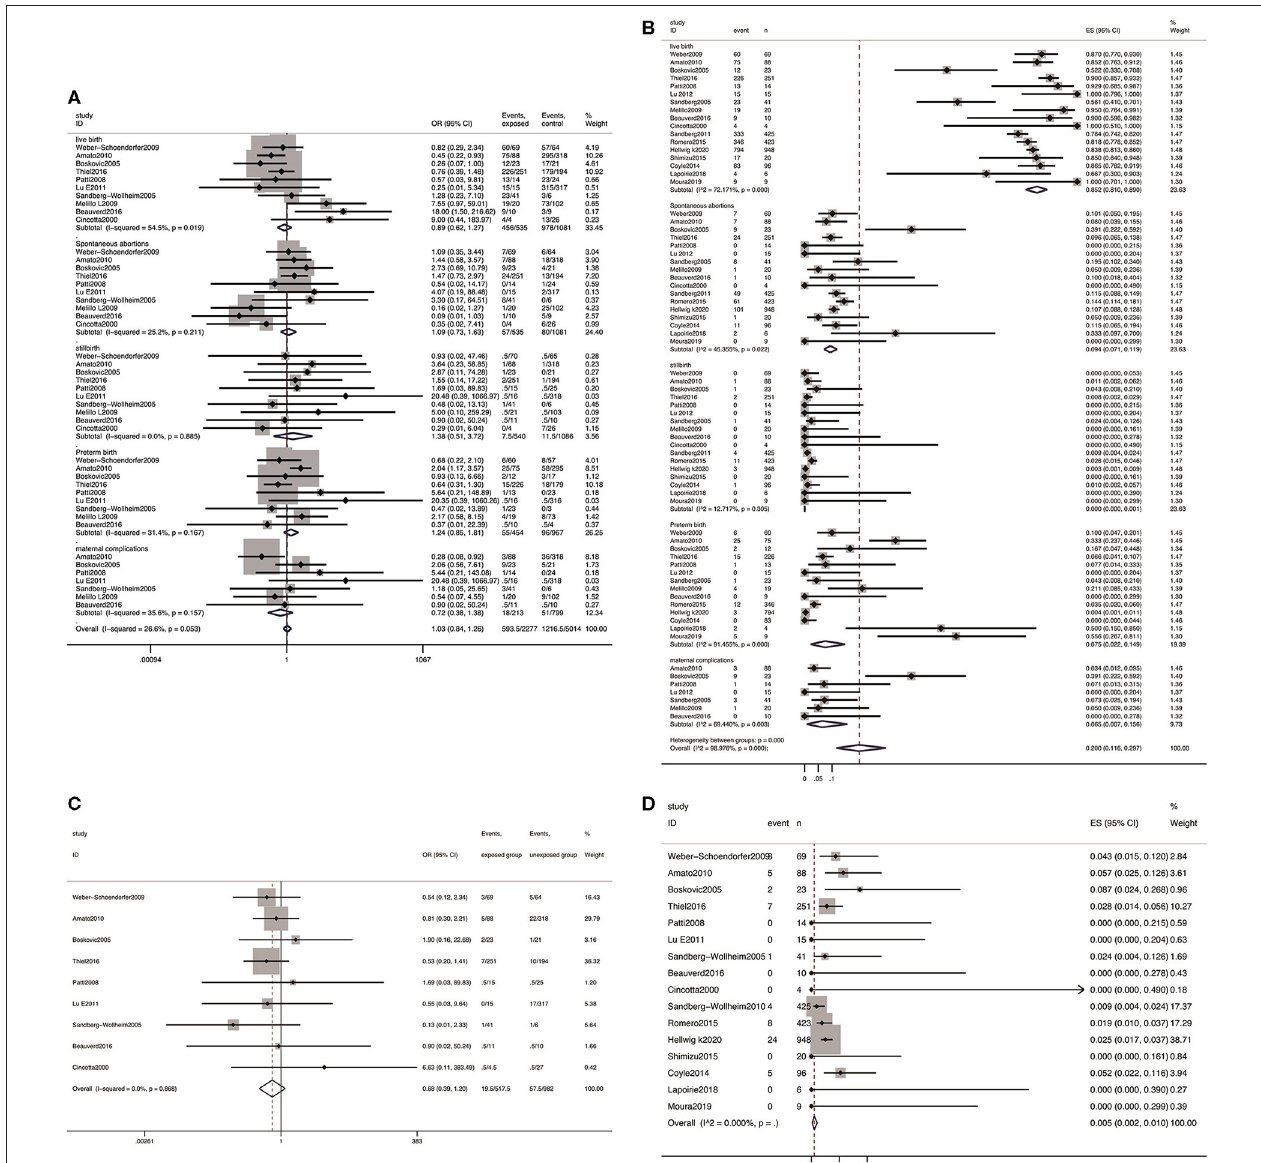
FIGURE 3 | Meta-analysis of pregnancy outcomes after IFN exposure. (A) The OR of pregnancy outcomes in IFN-exposed group compared with un-exposed group; (B) the pooled rate of each pregnancy outcome in IFN-exposed patients; (C) the OR of birth defects in IFN-exposed group compared with un-exposed group; and (D) the pooled rate of birth defects in IFN-exposed